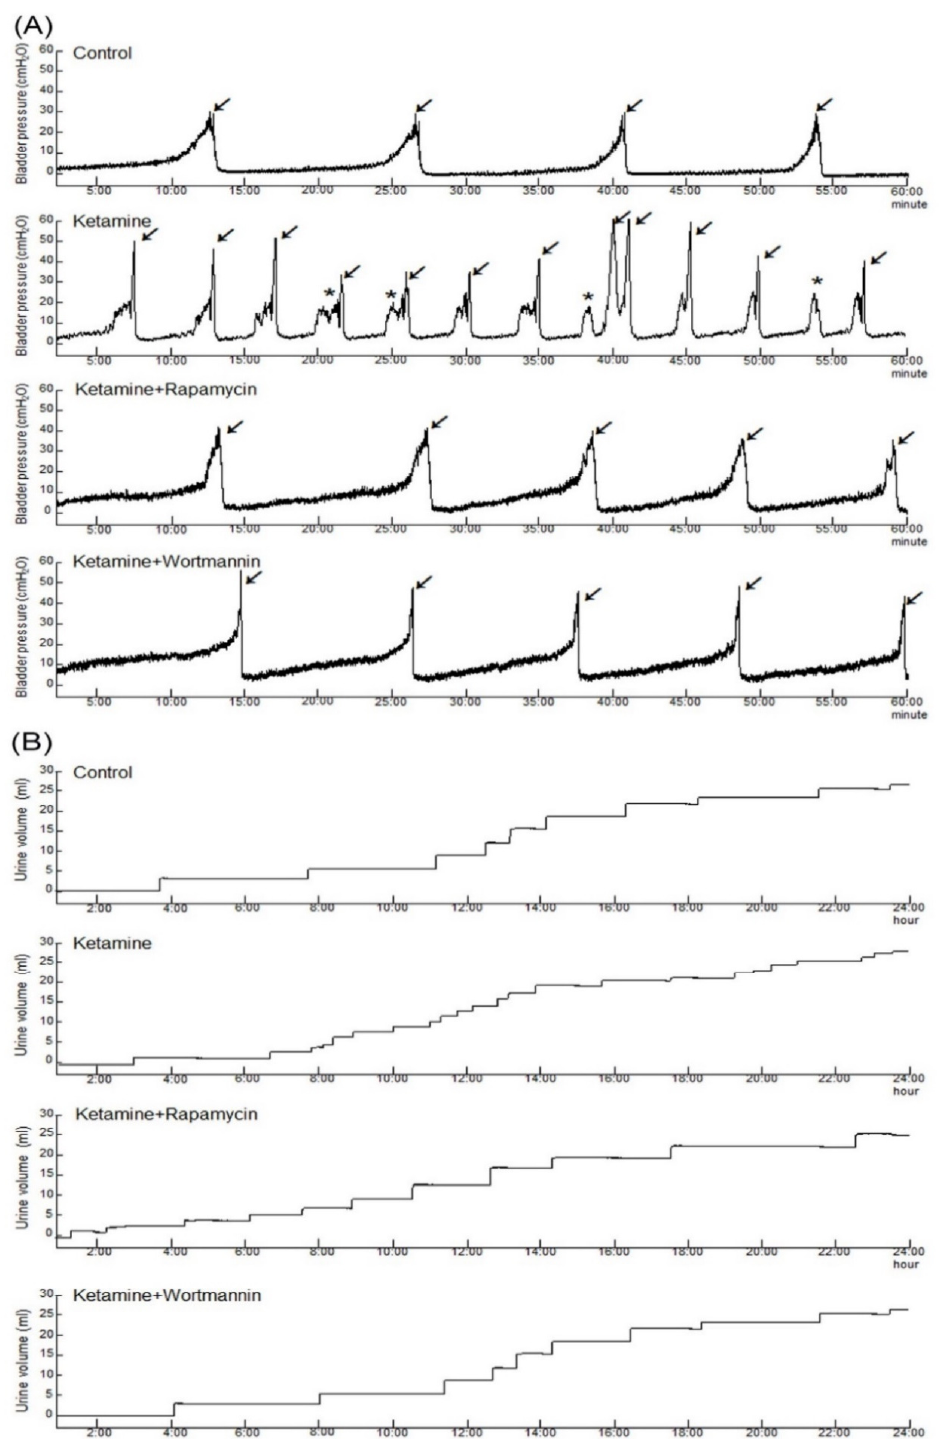
Figure 1. Bladder cystometric parameters and voiding behavior were shown in a KIC rat model. ( A ) Cystometry record- ings of micturition pressure, voiding volume, and frequency, including voiding contraction (arrows) and non-voiding contraction (asterisks) in 60 min. ( B ) Tracing analysis of 24 h voiding behavior by metabolic cage, illustrating that the ketamine group significantly increased bladder maturation pressure, voiding contractions, non-voiding contractions, and micturition frequency. However, such increases were significantly reduced in the ketamine+rapamycin group and the ketamine+wortmannin